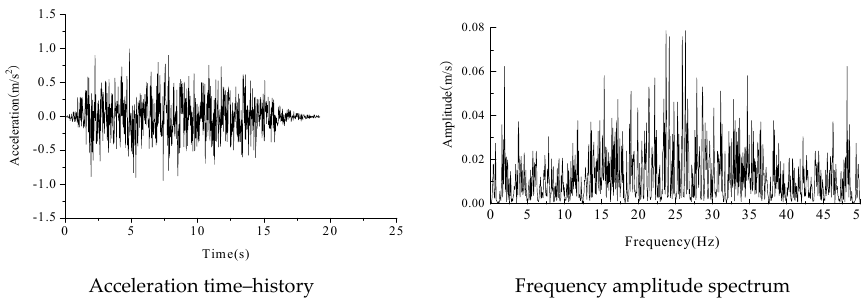
Figure 13. Lanzhou motion in the horizontal direction after inversion.